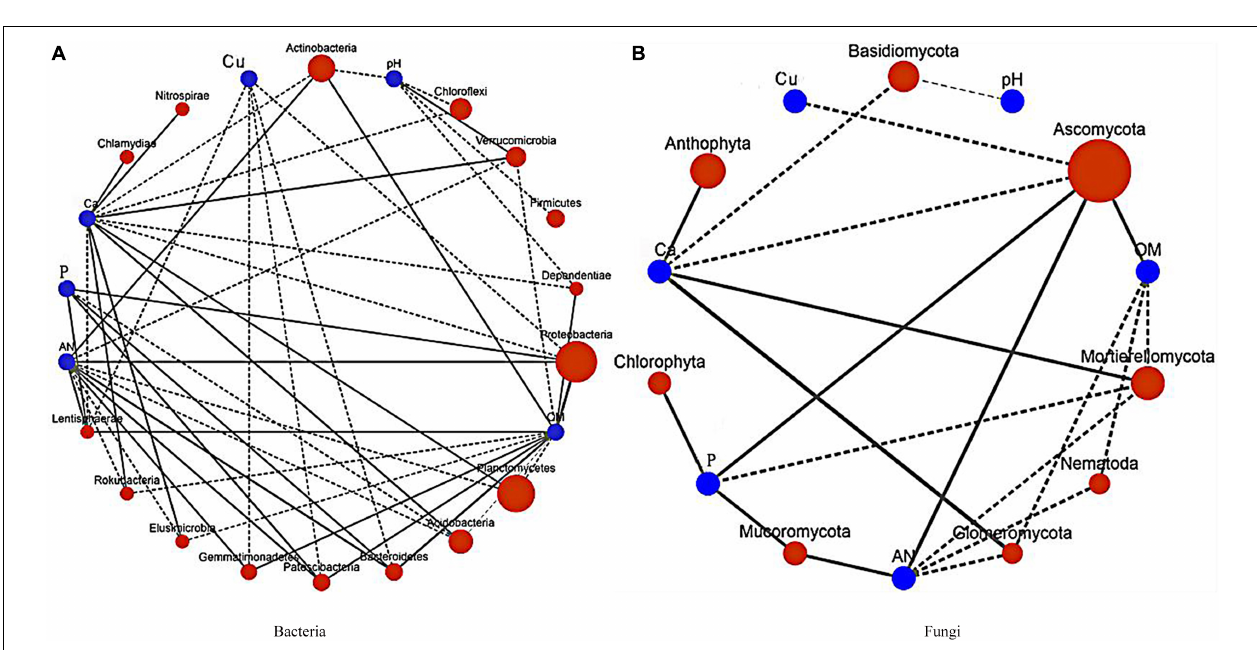
FIGURE 8 | Correlation diagram showing the relationships between the dominant bacteria and fungi and the soil physical and chemical index network. P, available potassium; Ca, exchangeable Ca; Cu, available Cu; OM, organic matter; and AN, alkali-hydrolyzable nitrogen. (A) Correlation network of the dominant bacteria and the soil physical and chemical index. (B) Correlation network of the dominant fungi and the soil physical and chemical index.